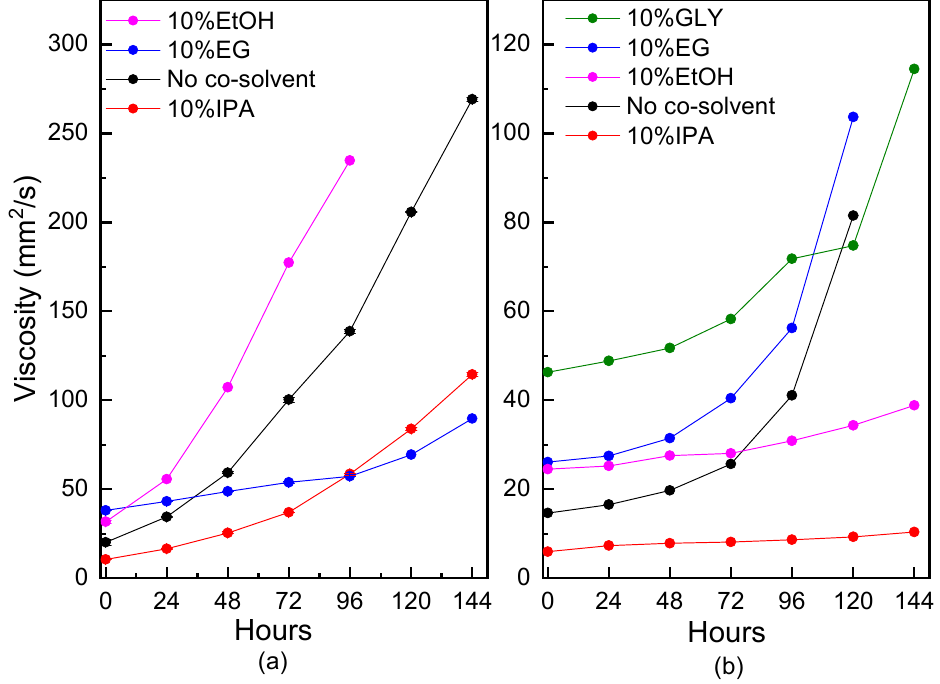
Figure 4. Biocrude viscosity measured with a BS / IP / RF U-Tube reverse flow viscometer ( a ) and a Zeitfuchs cross-arm viscometer ( b ).